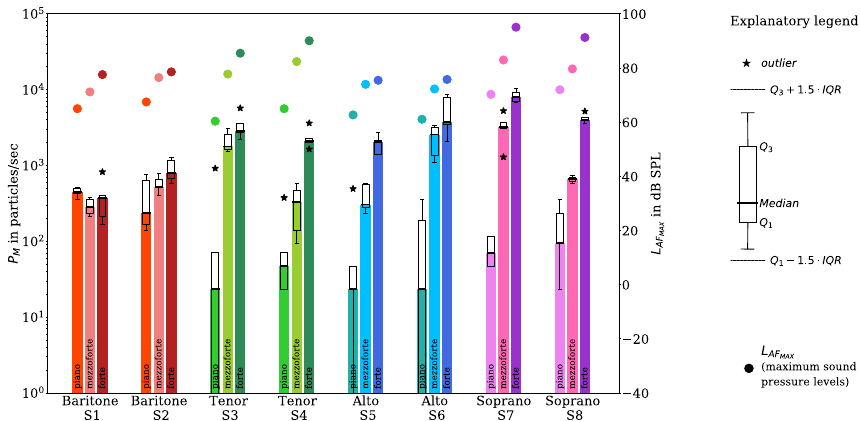
Figure 3. Boxplots of the emission rates (left y-axis; bars represent the median for all replications of each task) while sustaining the vowel /a ː / in experiment II for the different vocal loudness conditions piano, mezzo-forte, and forte and voice classifications (baritone (red), tenor (green), alto (blue), soprano (magenta), as denoted in the x-axis). For the different loudness conditions, the medians of maximum sound pressure levels L AF MAX are also shown (full circles, right y-axis). All symbols and colors correspond to the detailed description given in Fig. 2. (Figure created with matplotlib 3.2.1, http:// matpl otlib. org) .